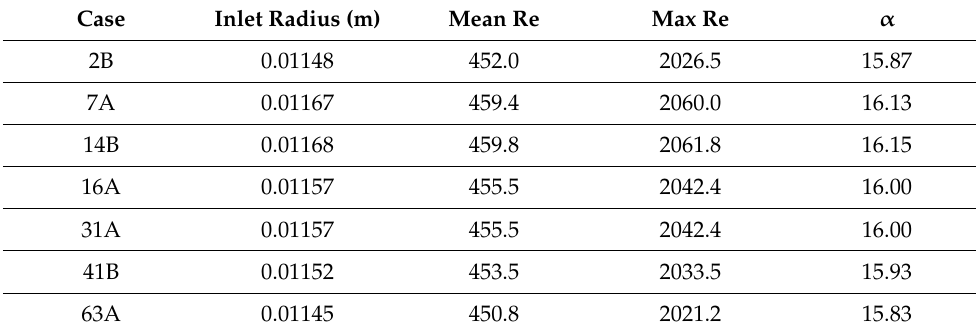
Table 1. Mean and peak inlet, Re, as well as Womersley parameter, α